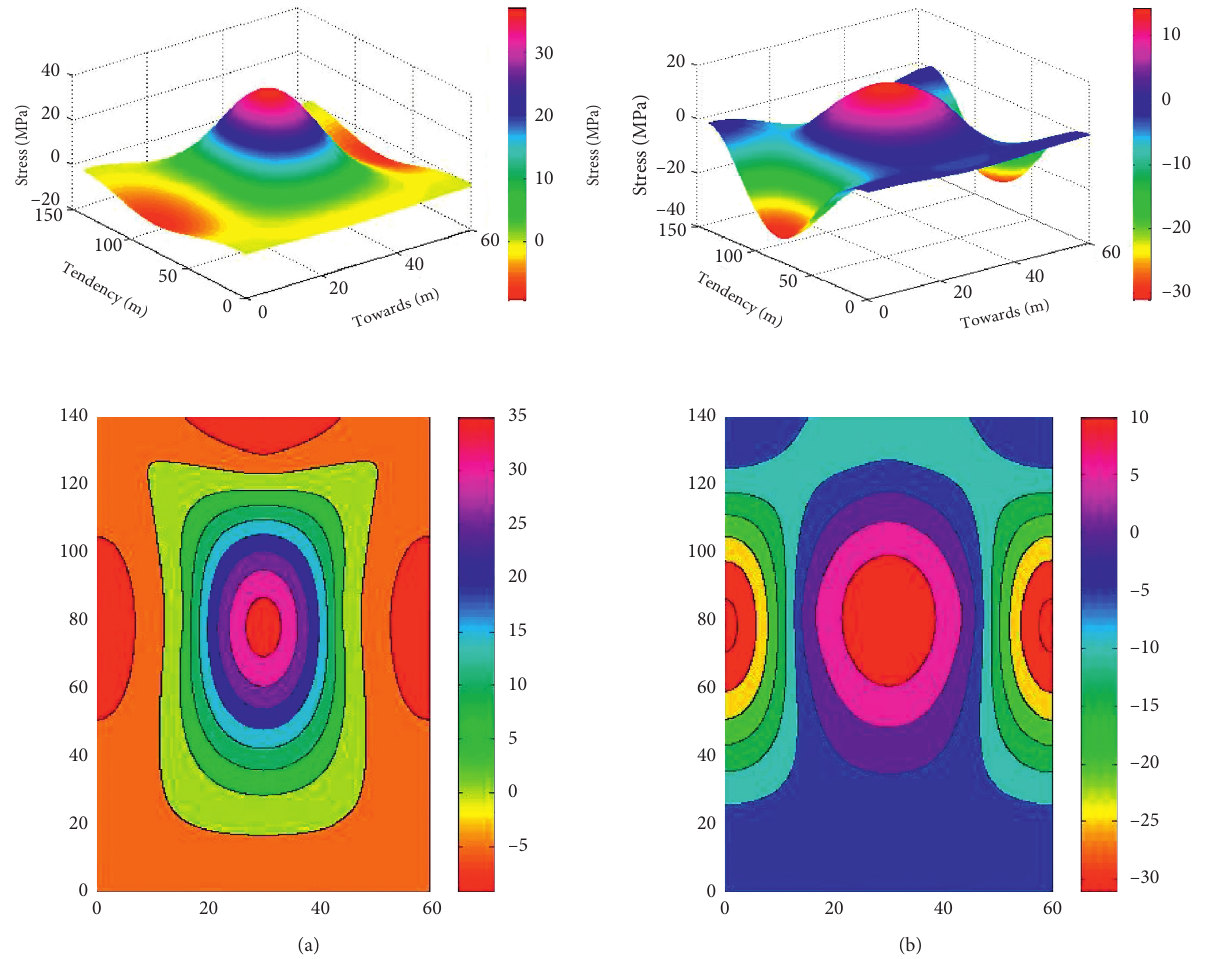
Figure 3: Neophogram of the principal stress in the main roof. (a) σ